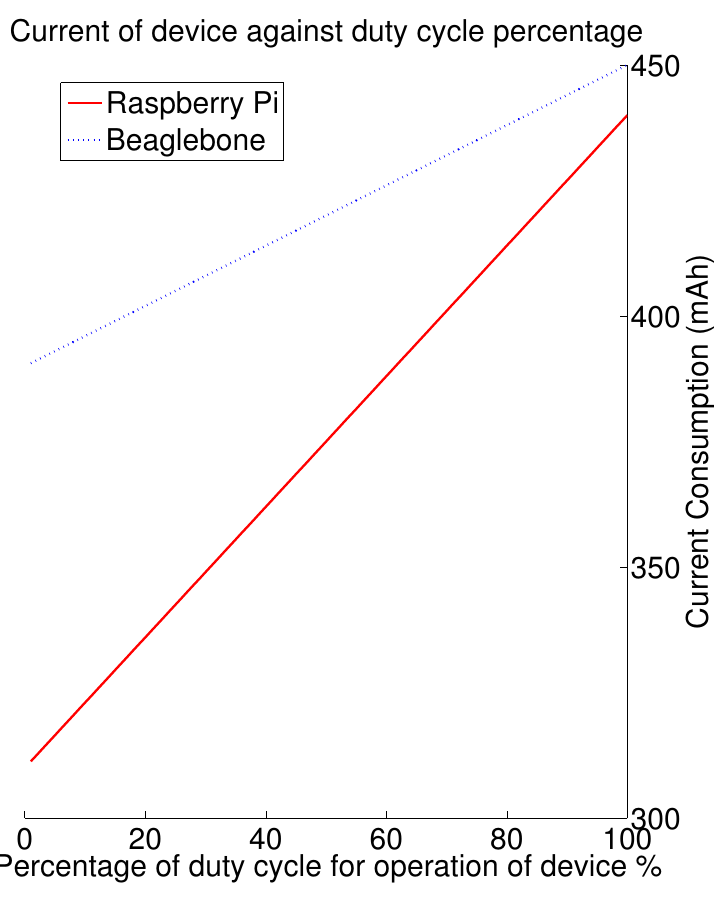
Figure 5. Non-traditional nodes’ current consumption against duty